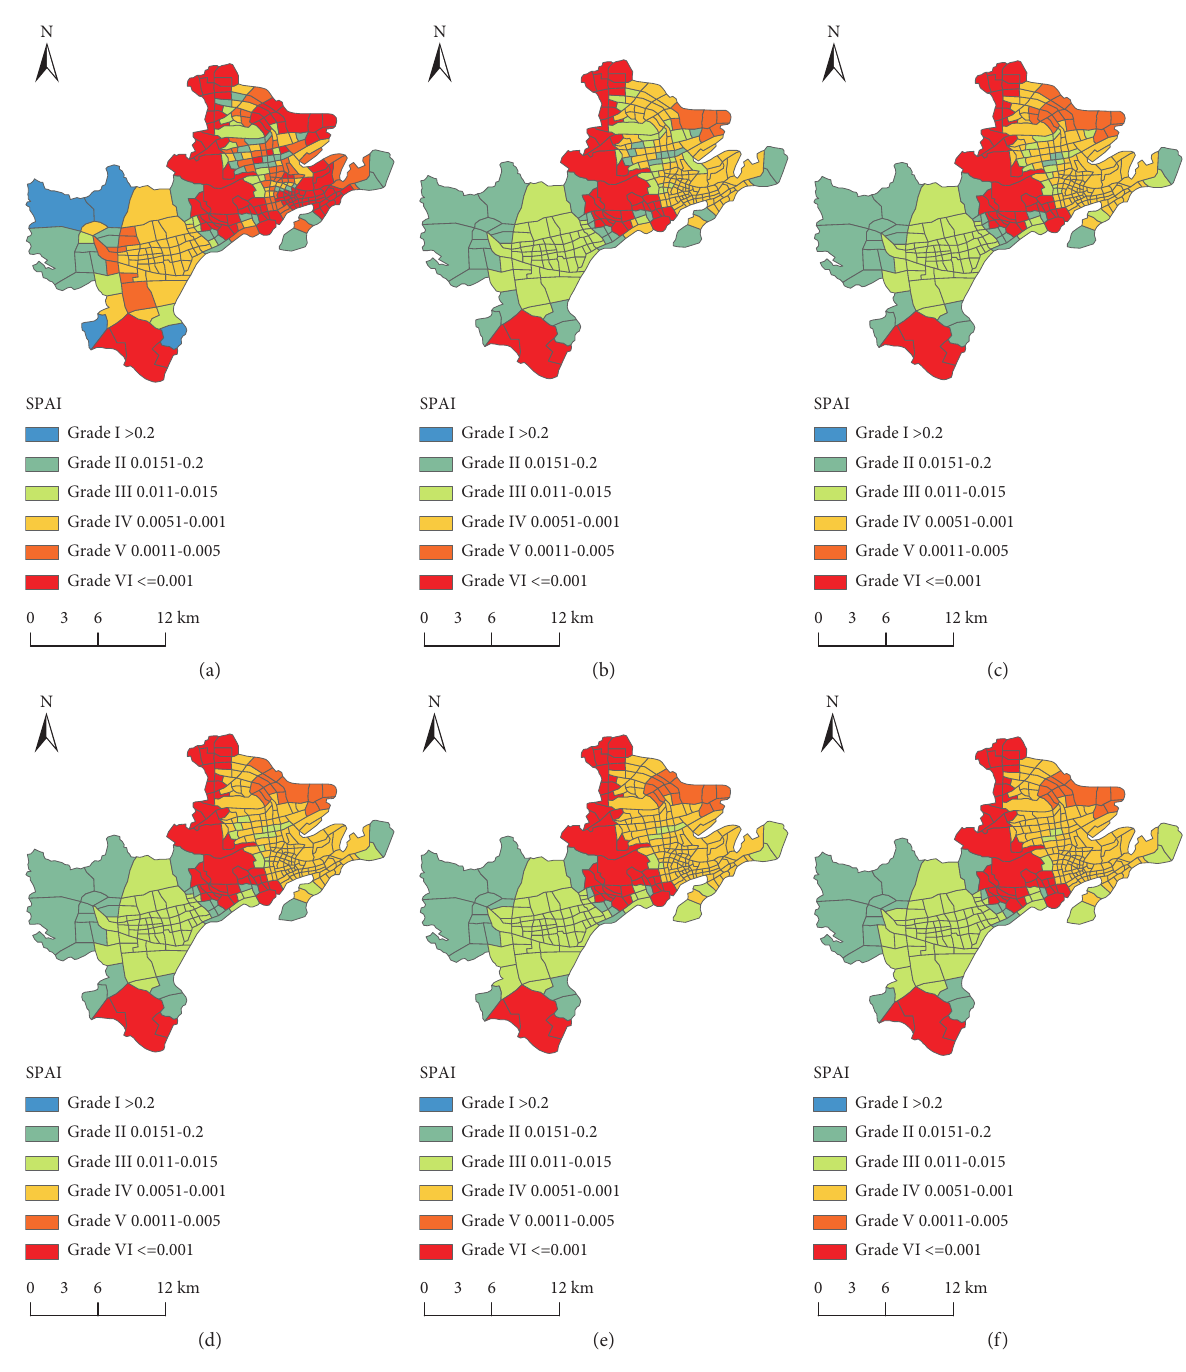
Figure 4: The geographic patterns of spatial access index (SPAI) with different impedance coefficients. (a) β � 10. (b) β � 25. (c) β � 40. (d) β � 55. (e) β � 70. (f) β �